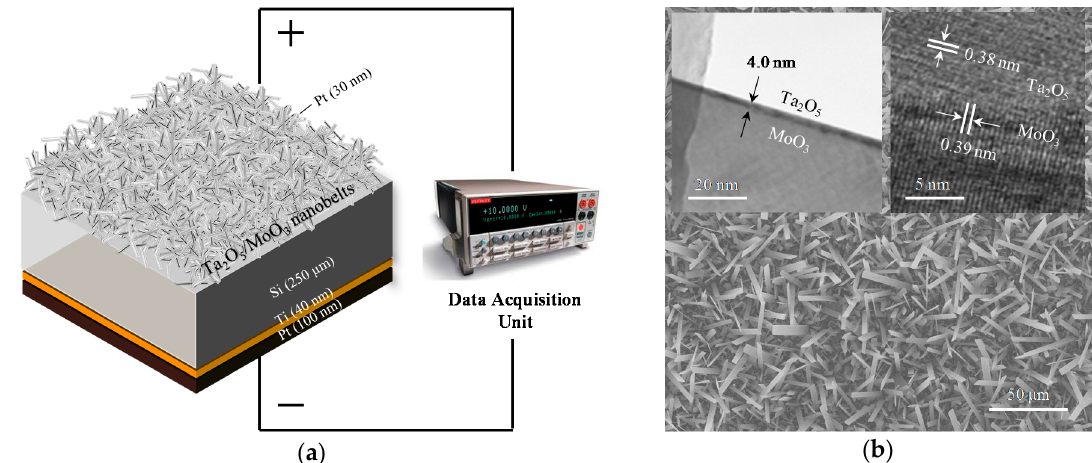
Figure 1. ( a ) Device structure with connection to the data acquisition unit. For the Schottky contact, Pt is deposited directly on the MoO 3 nanobelts. For the heterojunction, Ta 2 O 5 , then Pt, are deposited. ( b ) Scanning electron microscopy (SEM) of the MoO 3 nanobelts depicting average lengths and widths of 20 µ m and 2 µ m, respectively. The left inset shows a transmission electron microscopy (TEM) of the high- k layer with a thickness of 4 nm. The right inset shows the high resolution TEM (HRTEM) of the Ta 2 O 5 /MoO 3 nanobelt interface with inter-planar atomic distances for these two materials at 0.38 nm and 0.39 nm, respectively.